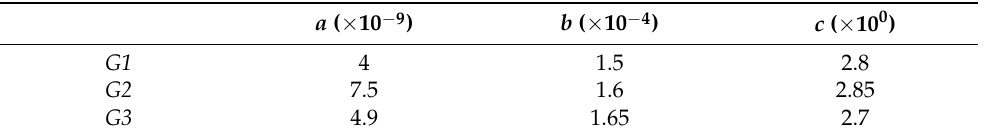
Table 1. Fitting parameters used in Equation (1) to remove humidity and temperature dependence on signals from the three graphene devices in our sensing